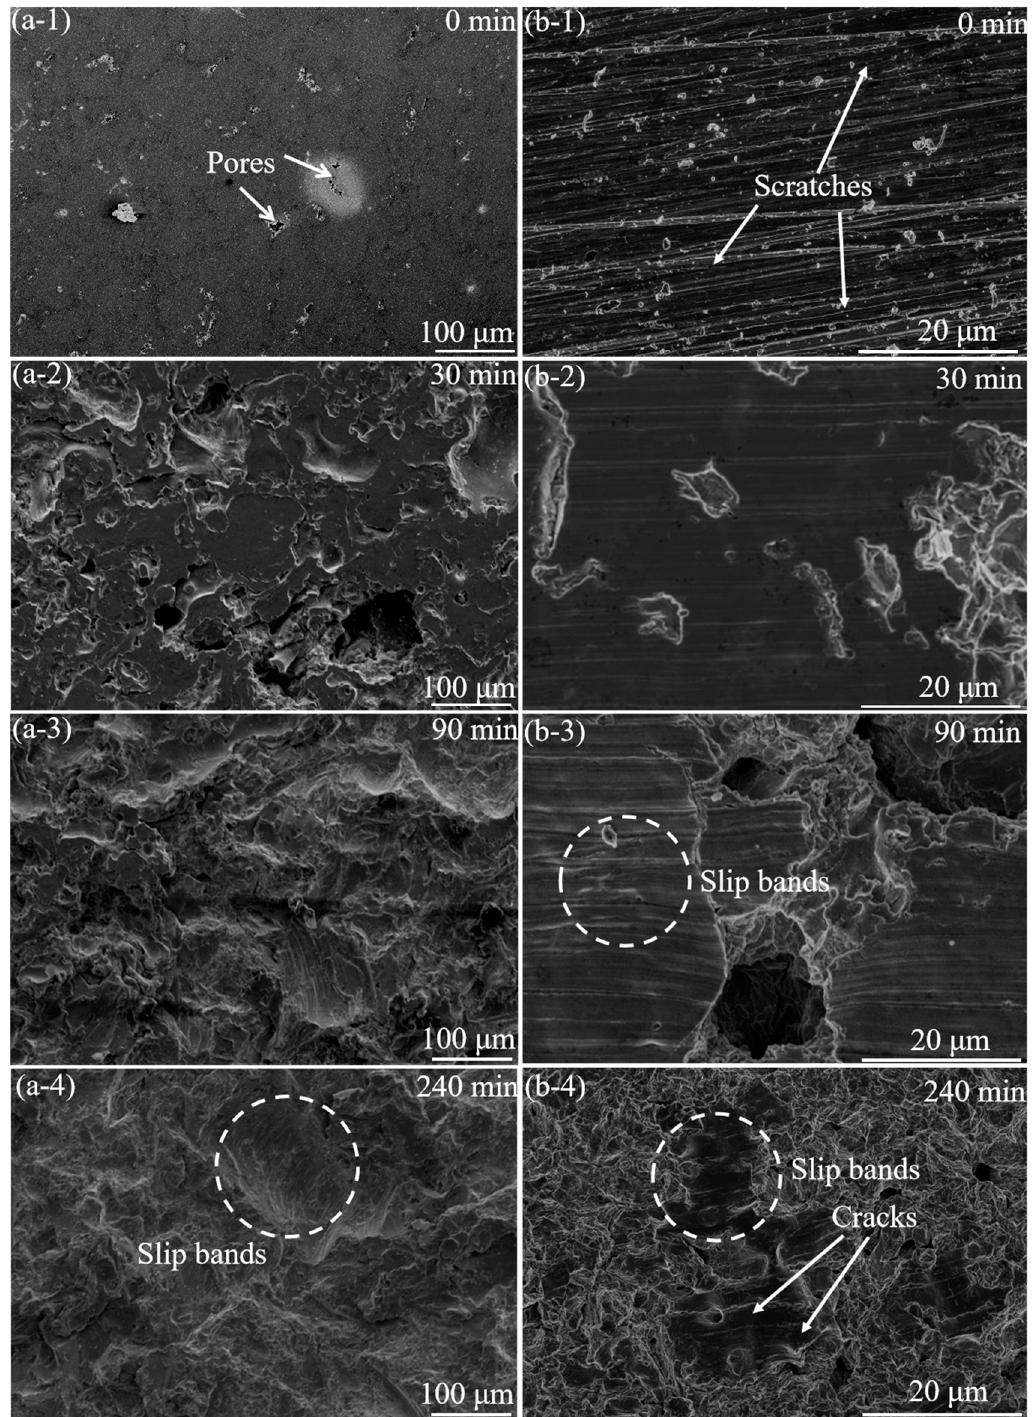
Figure 6. Surface of the coating ( a ) and ground coating ( b ) specimens before and after cavitation